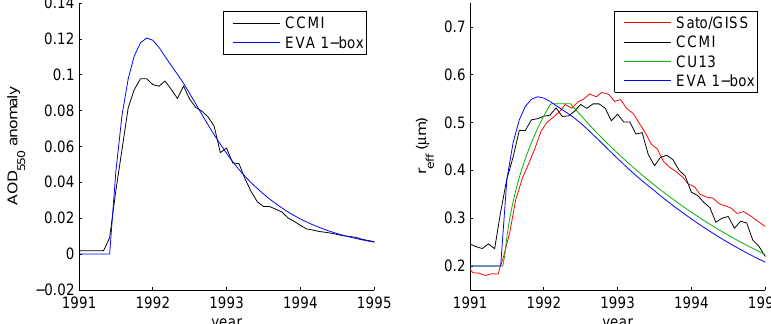
Figure 1. Left: global mean AOD 550 anomaly time series from CCMI (Arfeuille et al., 2013) following the Pinatubo eruption, and the repro- duction via the EVA, single-box model approach (see text). Right: global mean aerosol effective radius time series from the reconstructions of Sato/GISS (Sato et al., 1993, 2012), the CCMI data set, CU13 (Crowley and Unterman, 2013) and the EVA single-box model